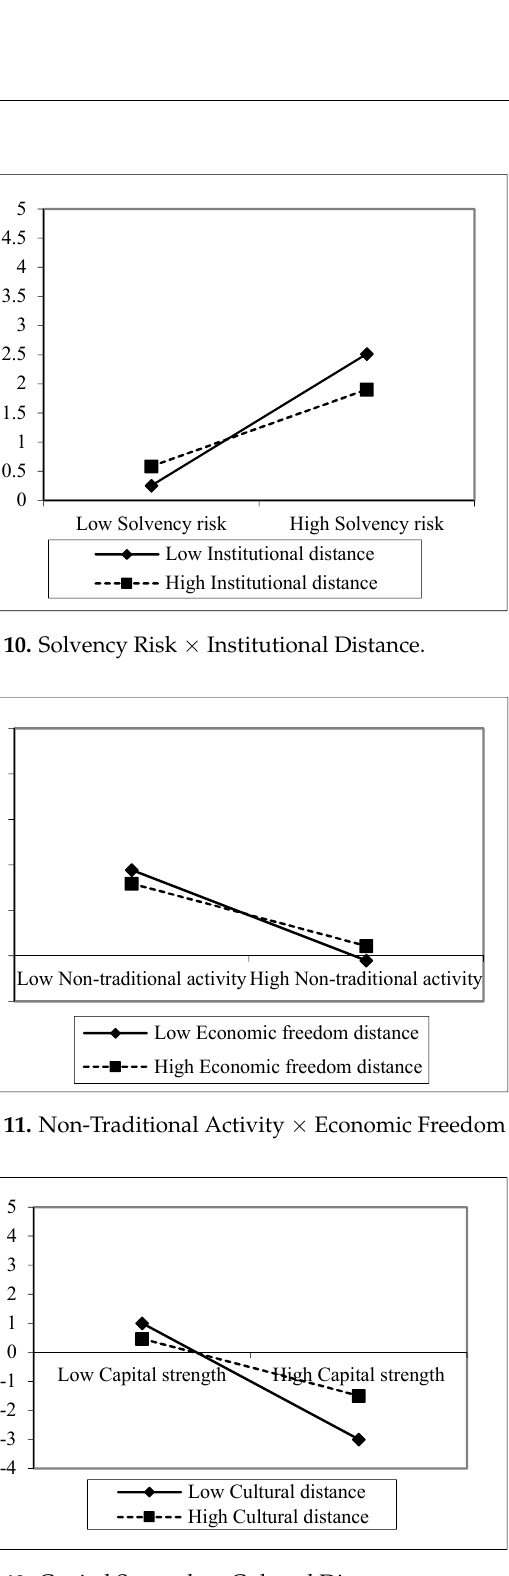
26 of 38 Figure 8. Bank Branch × Cultural Distance.